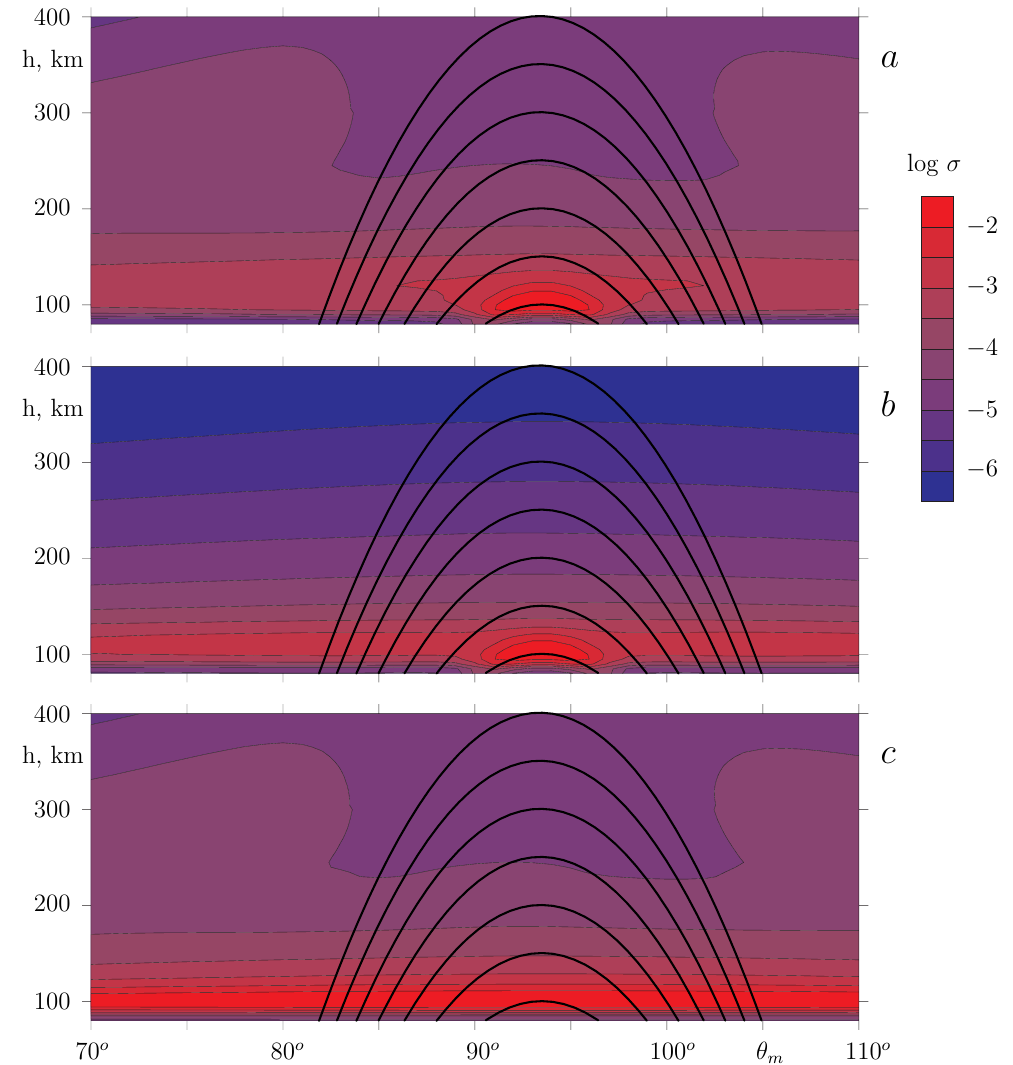
Fig. 9. The same as Fig. 8 but near the midday point ϕ m = 180 ◦ at the geomagnetic equator.